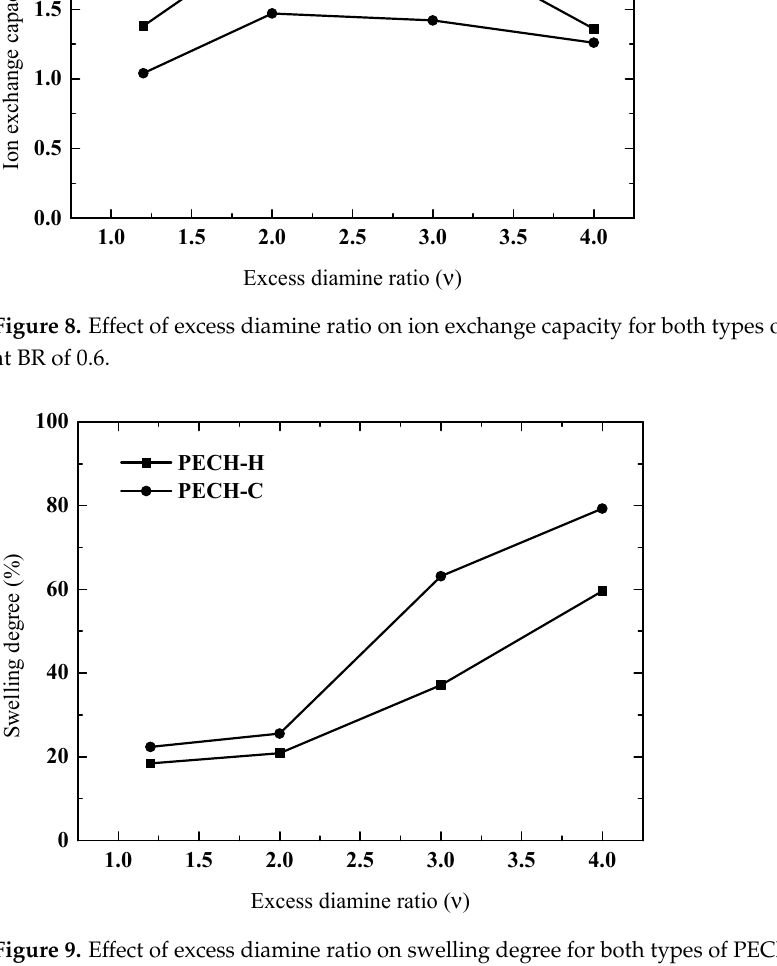
Figure 9. Effect of excess diamine ratio on swelling degree for both types of PECH membrane at BR= 0.8.